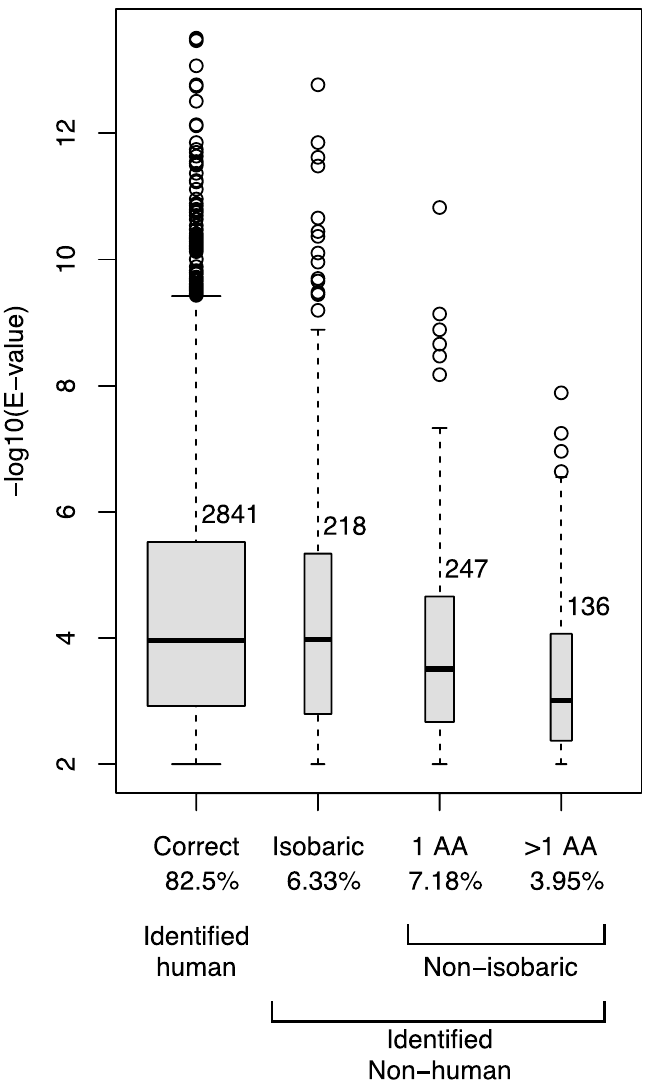
Figure 2. E-values of peptides identified by MS/MS in 19 human bone samples searched against a vertebrate database. Boxplots show distributions of E-values of spectra that matched to human peptides (correctly identified) (left) and spectra that matched only to non-human peptide sequences (incorrectly attributed). Width of boxes correspond to the number of spectra in each category, also printed above each box. Incorrectly attributed peptides differ from human consensus sequence peptides by one or more amino acids. These amino acid differences can be isobaric or non-isobaric. A post hoc Tukey test revealed correct peptides and isobaric peptides to be statistically similar and 1 AA and > 1 AA peptides also to be to be statistically similar. All other comparisons were significantly different (p <